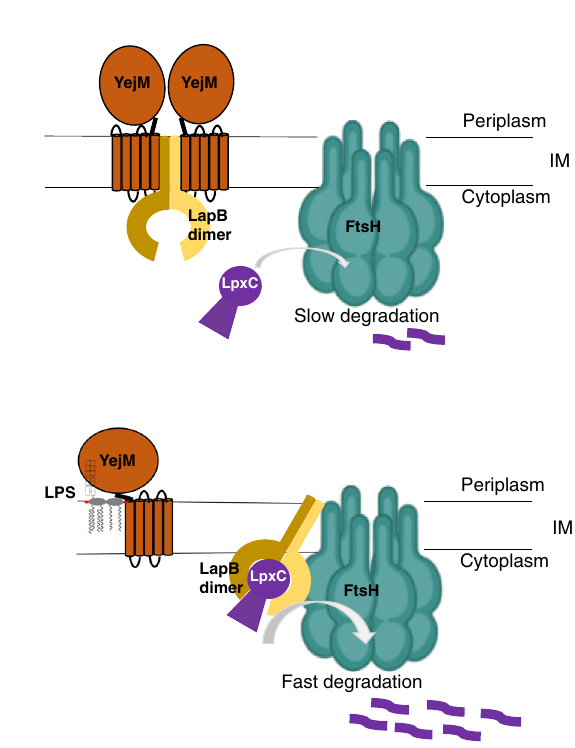
Fig.5|ModelforregulationofLpxCdegradation.a Inexponentialgrowthphase, YejM and LapB form a stable complex, and FtsH degrades LpxC slowly. b In sta- tionary phase, LPS accumulates in the IM, displacing the LapB dimer from YejM. The liberated LapB dimer binds to FtsH,acts as an adaptor protein, and stimulates LpxC